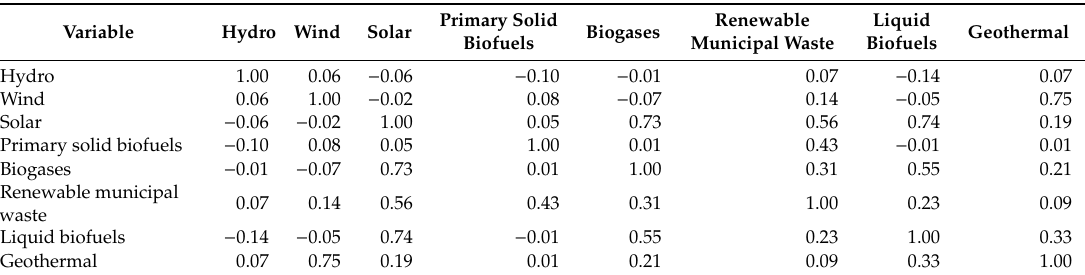
Table 12. Correlation coe ffi cients for energy production from selected renewable energy sources in the EU countries per 1 km 2 in 2017 (own study).